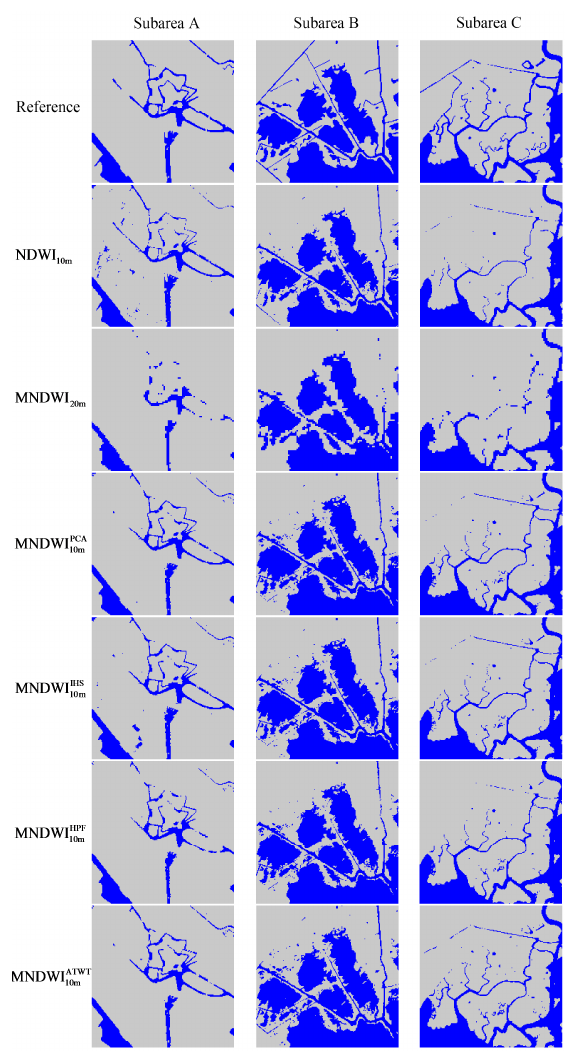
Figure 6. Subarea reference 10-m water body maps and 20-m and 10-m water body maps extracted from the sub-area NDWI and MNDWI images shown in Figure 4. Table 5. Kappa, Overall Accuracy (OA), omission error and commission error of resultant water body maps in Subareas A, B and C.